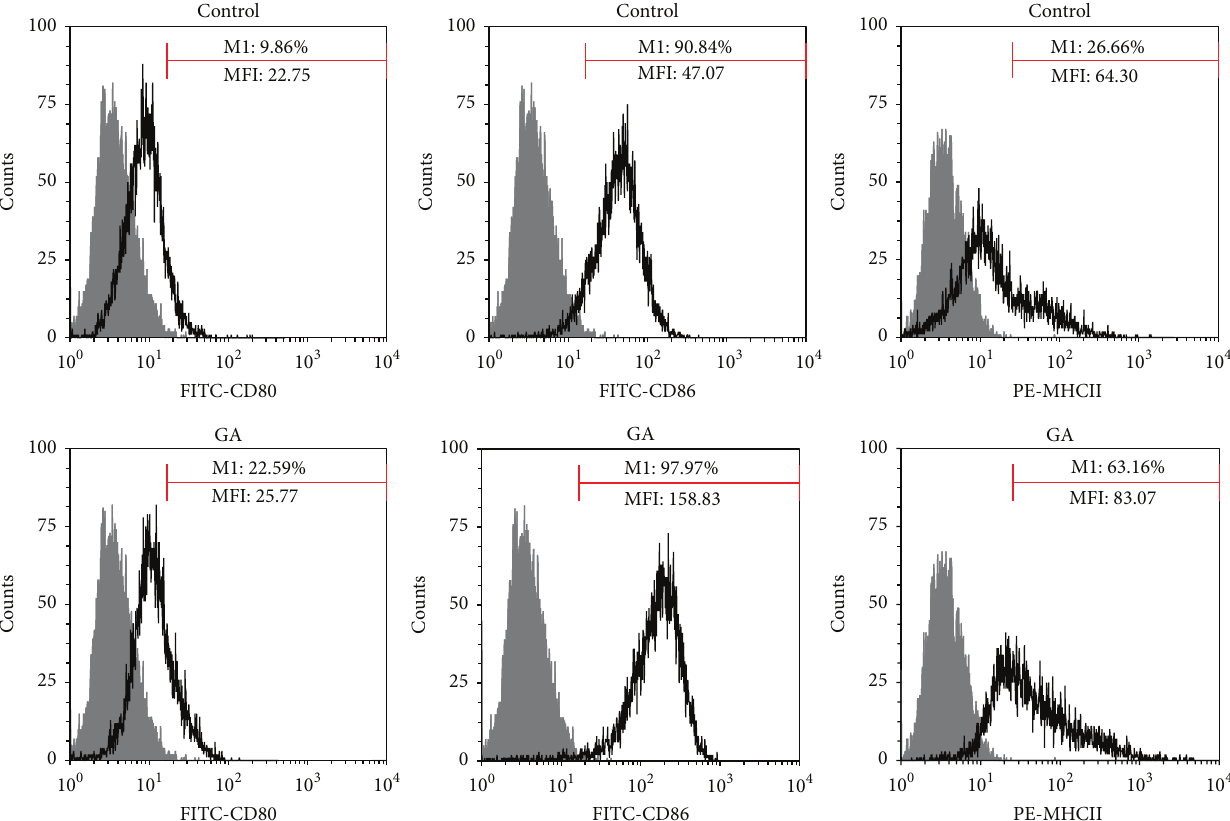
Figure 2: The activation profiles of BMDMs treated with GA. BMDMs were treated with GA (100 𝜇 g/mL) for 48 h. Cells were harvested and stained with antibodies to CD80, CD86, and MHCII. Expressions of the surface molecules were analyzed by FACS and displayed, respectively, by the single parameter diagram. The values shown in the profiles were the gated % and the MFI. Results are representative of three independent